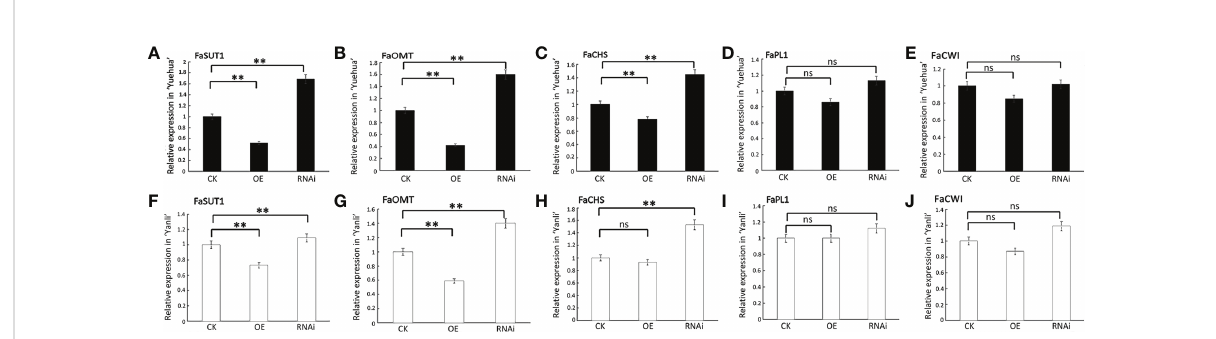
FIGURE 6 FveARF2 involved in strawberry fruit ripening by regulating fruit ripening related genes. Relative expression levels of FaSUT1 , FaOMT , FaCHS , FaPL1 , and FaCWI in FveARF2 -OE and FveARF2 -RNAi in (A – E) ‘ Yuehua ’ and (F – J) ‘ Yanli ’ fruits, respectively. Values are the mean ± SD from three independent experiments with three biological replicates. ‘ ** ’ Indicates very signi fi cant differences (P < 0.01, Duncan ’ s multiple range test); ns indicates no signi fi cant